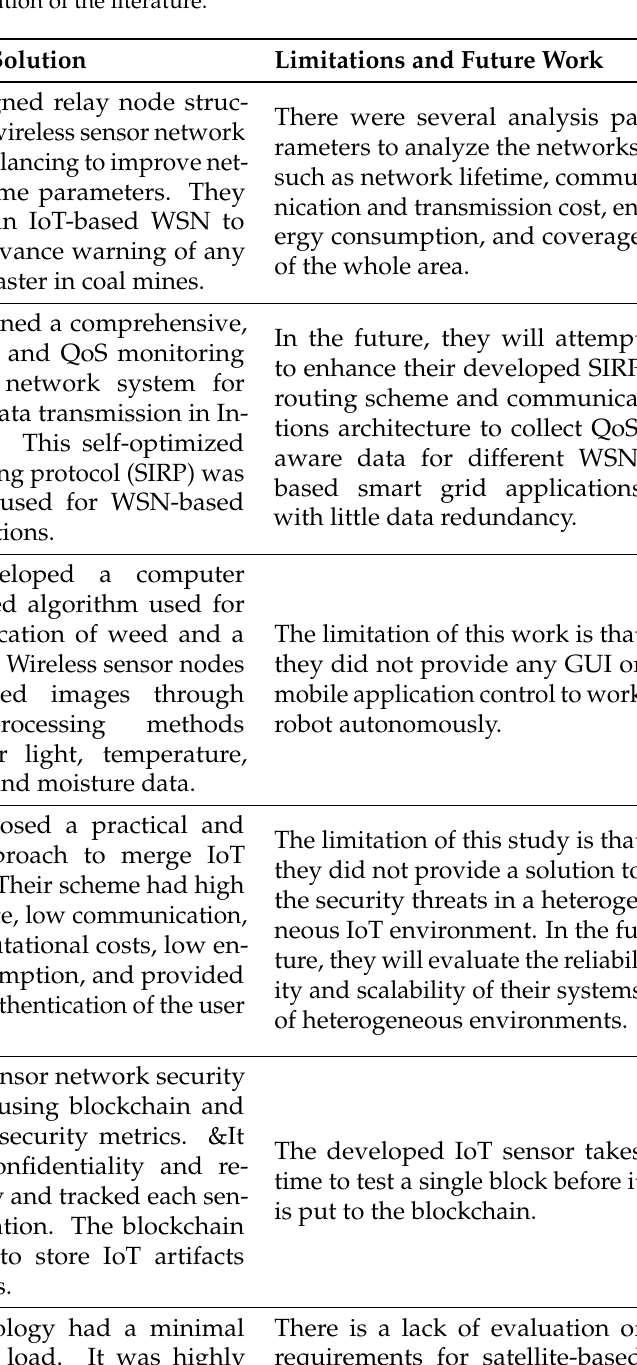
Table 9. Contributions and limitation of the